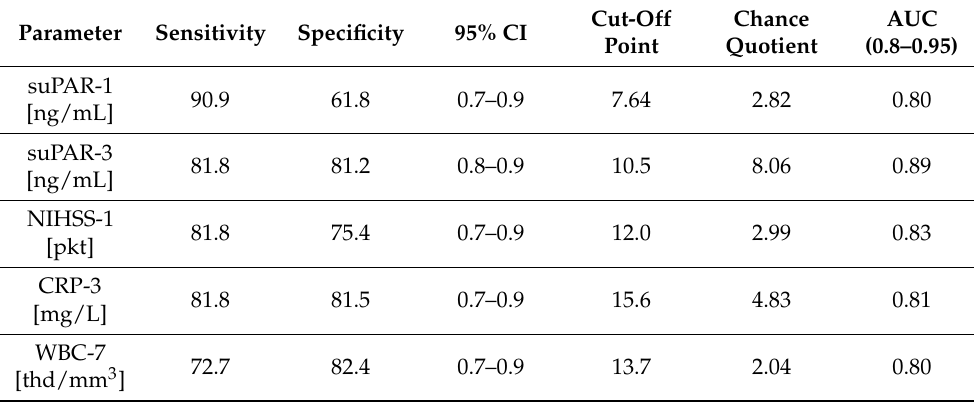
Table 5. Comparison of prognostic value of individual